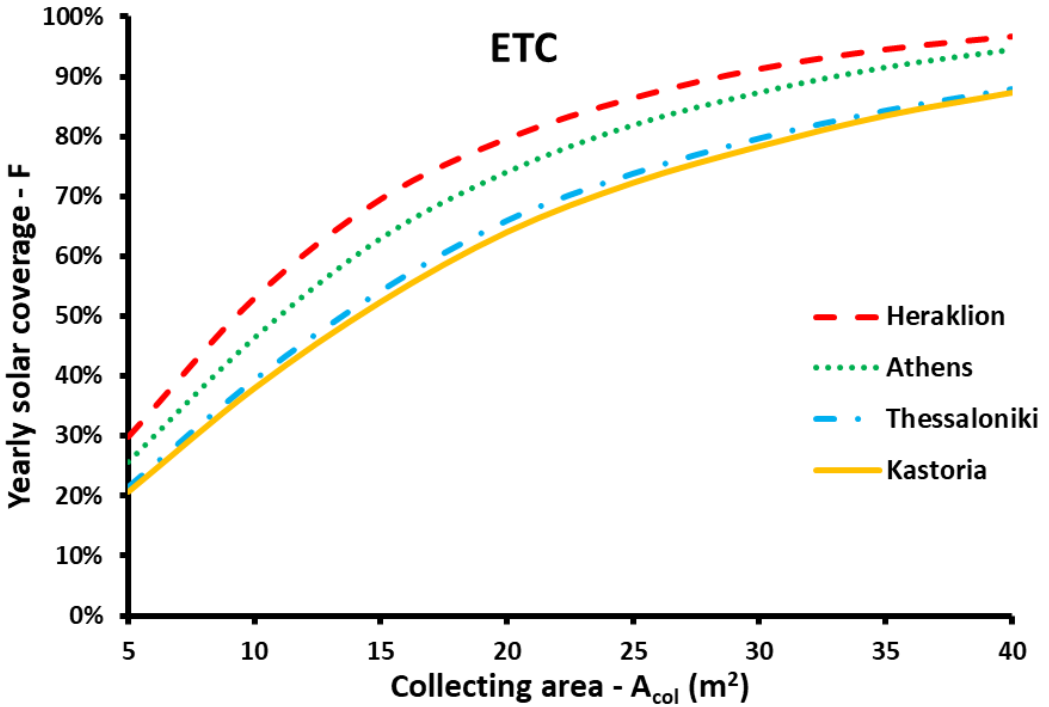
Figure 12. Yearly solar coverage with ETC for the examined locations with optimized tilt angle.